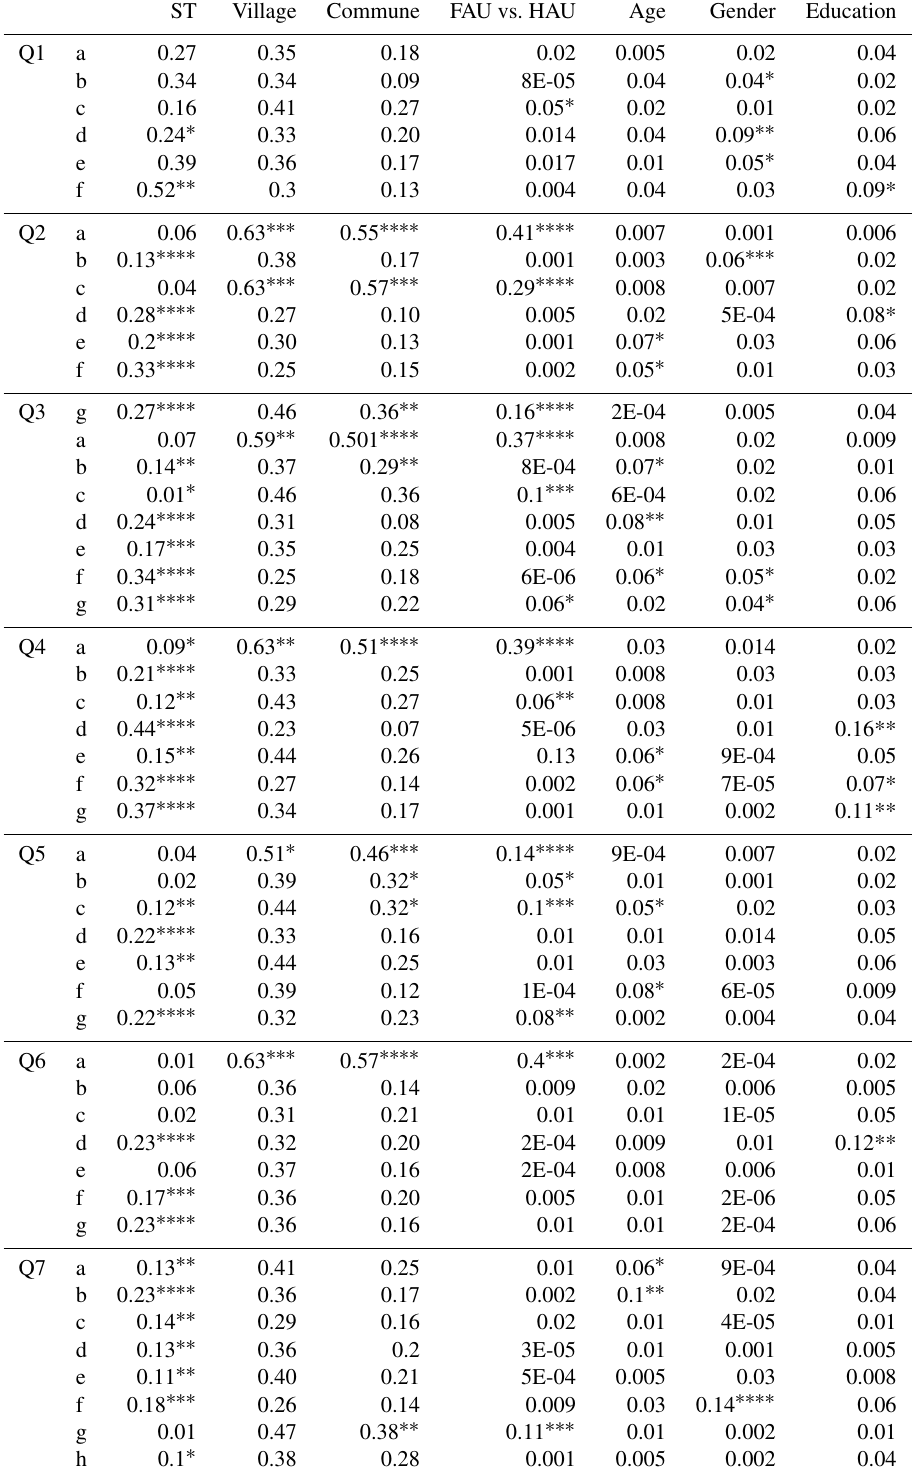
Table A3. The non-parametric-test results (the epsilon followed by the level of significance code) for question items by stakeholder types (STs), administrative unit (village and commune), floodplains vs. hilly areas (FAUs vs. HAUs), and demographic characteristics of stake-